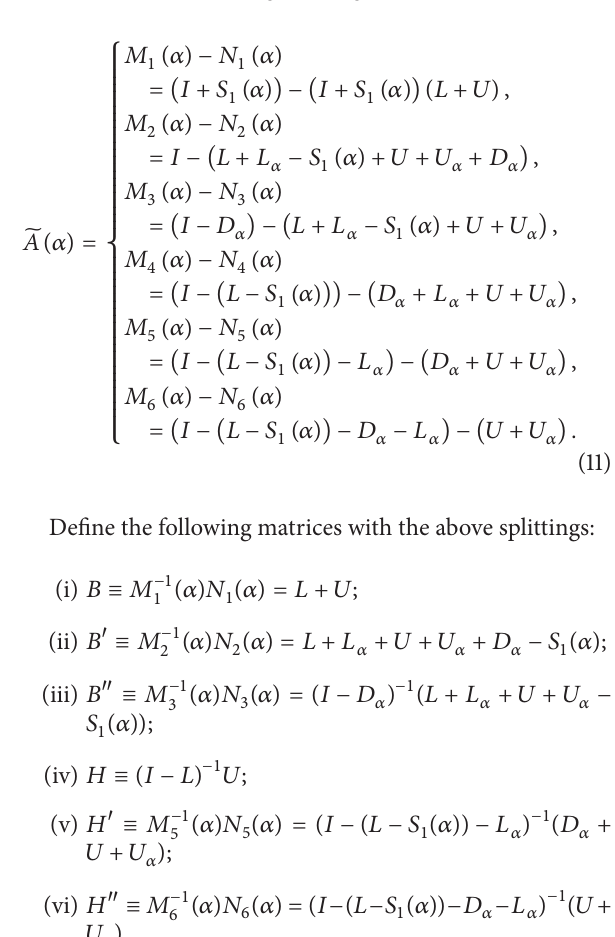
Algorithm 10 (synchronous multisplitting and